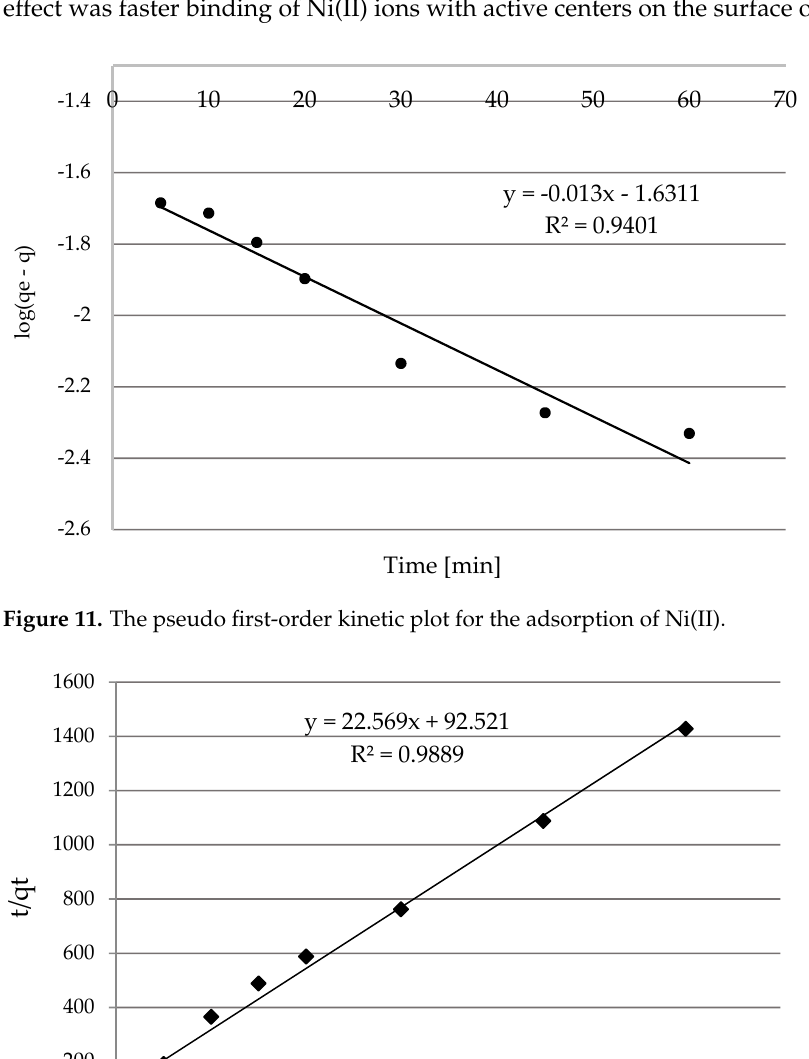
Table 3. Adsorption parameters of pseudo-first-order and the pseudo-second-order rate equations.